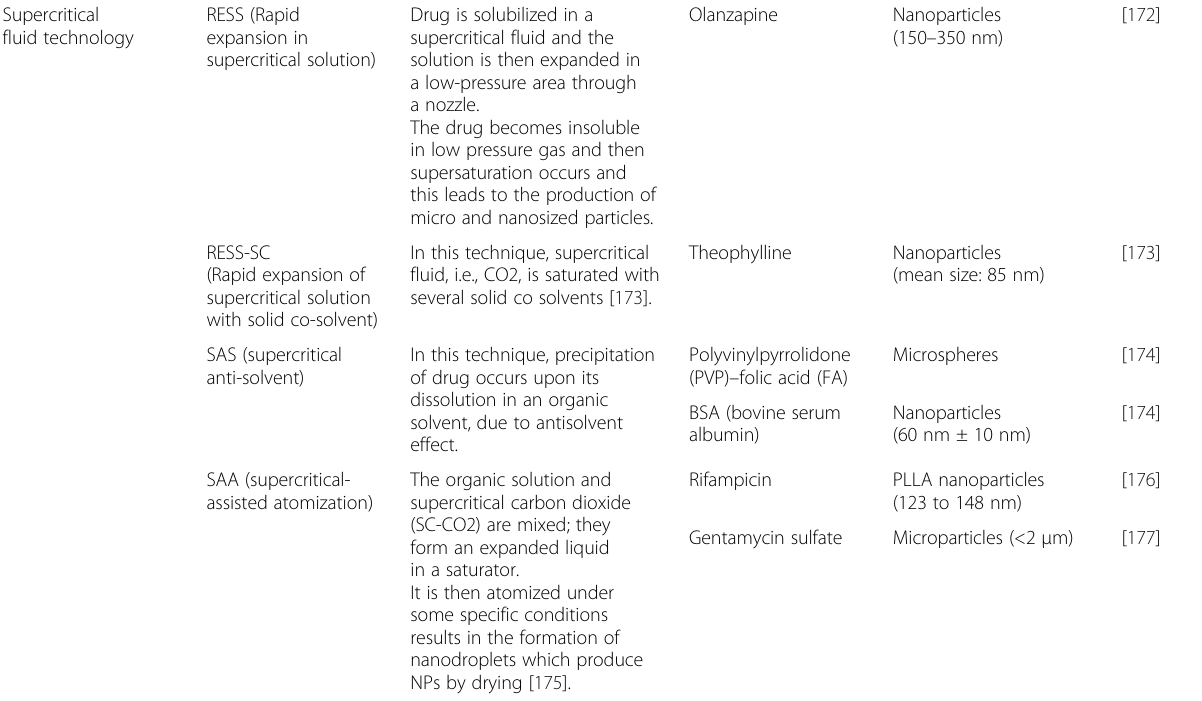
Table 2 Different approaches for manufacturing of various nanomaterials with their respective types (Continued) Supercritical fluid